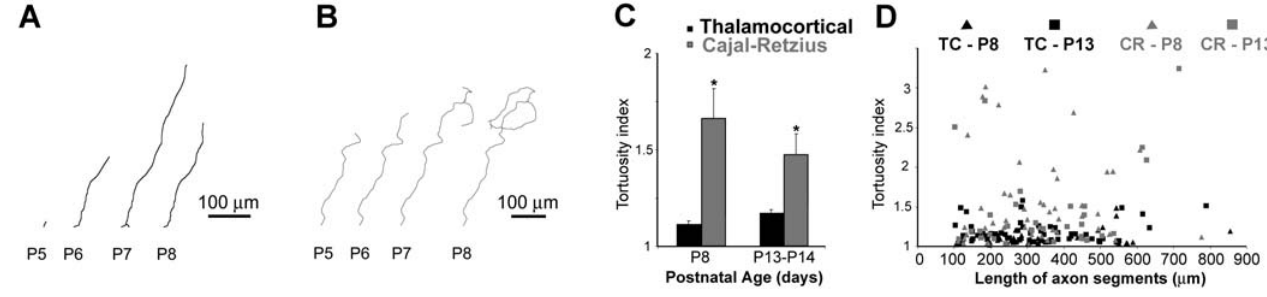
Figure 3. CR and TC Axonal Trajectories (A) Reconstruction of a TC axon segment over time (P5–P8). (B) Reconstruction of a CR axon segment over time (P5–P8).